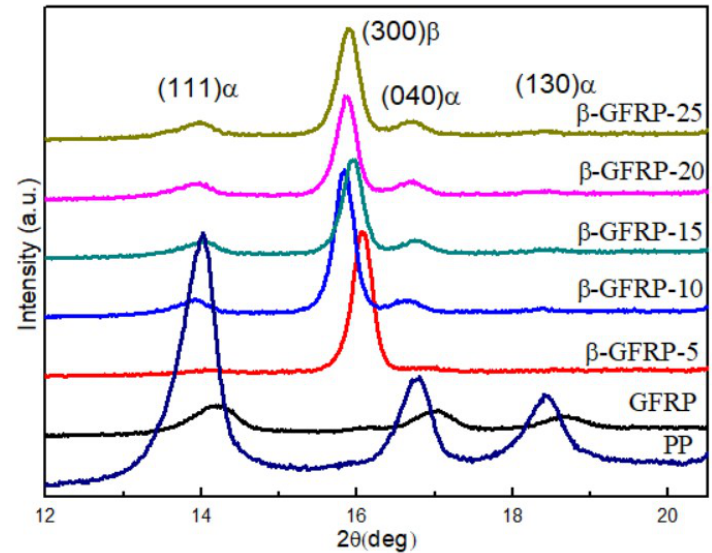
Figure 8. X-ray di ff raction (XRD) patterns of β -GFRP